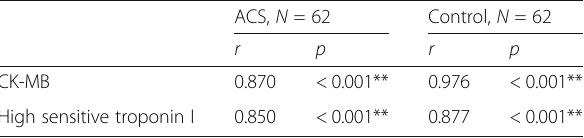
Table 4 Correlation of CD147 gene fold change with CK-MB and high sensitive troponin I